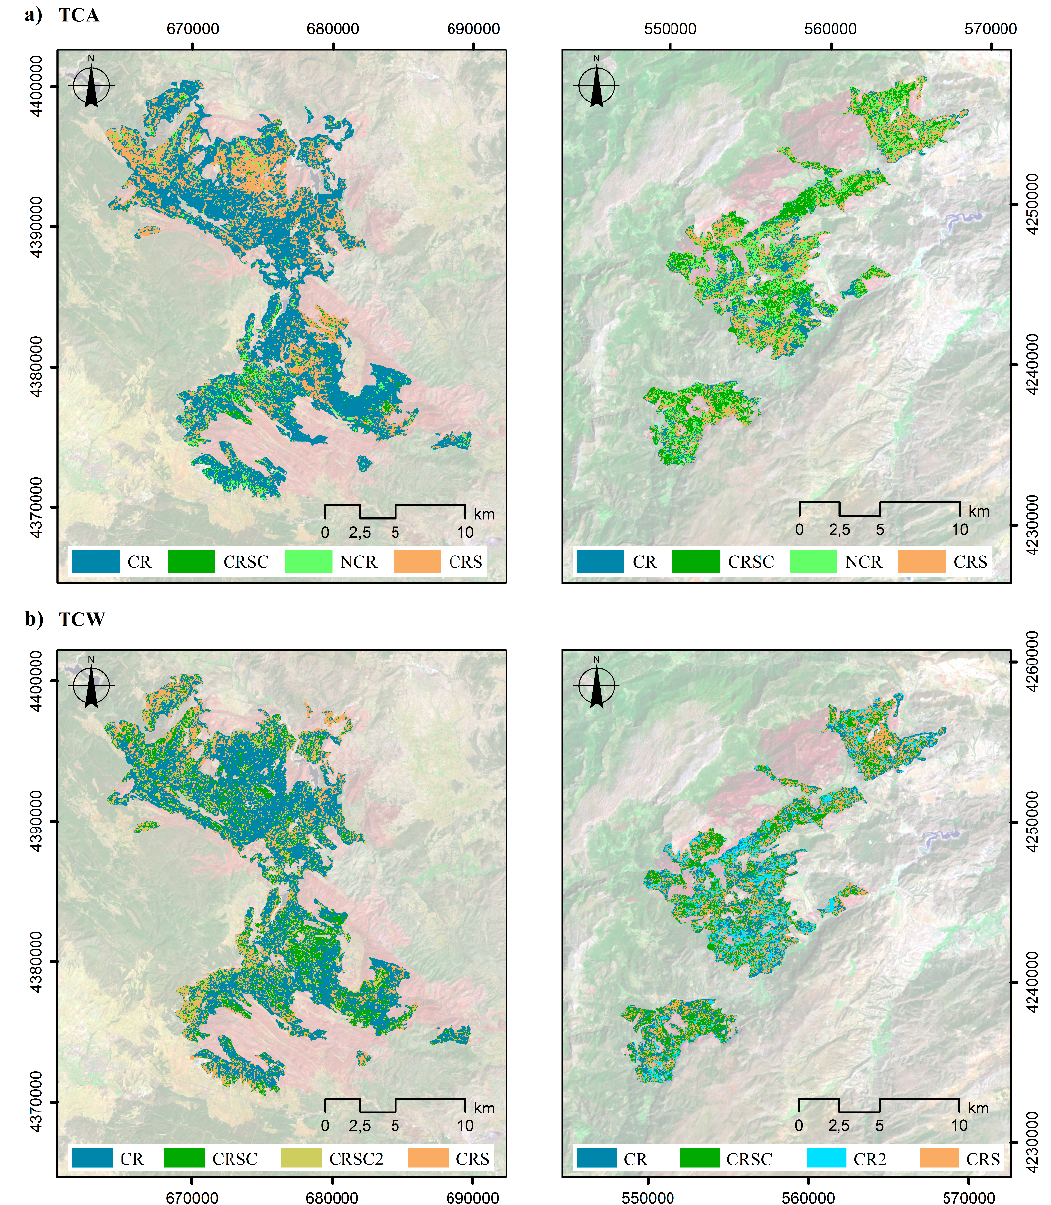
Figure 6. Maps of trajectory categories according to Tasseled Cap Angle (TCA; a ) and Tasseled Cap Wetness (TCW; b ). Requena (left), Yeste (right).